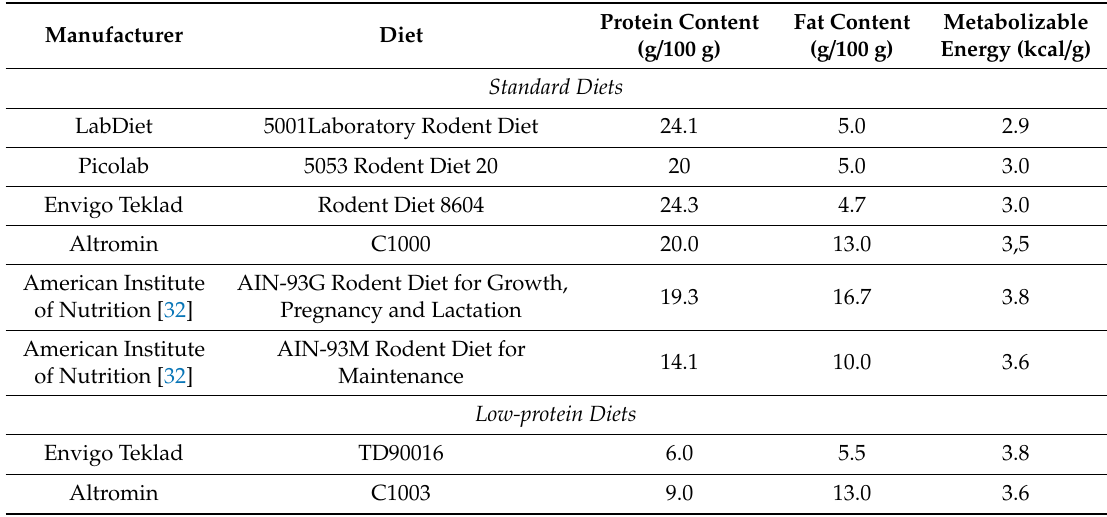
Table 1. Examples of commercially available normal or low-protein rodent